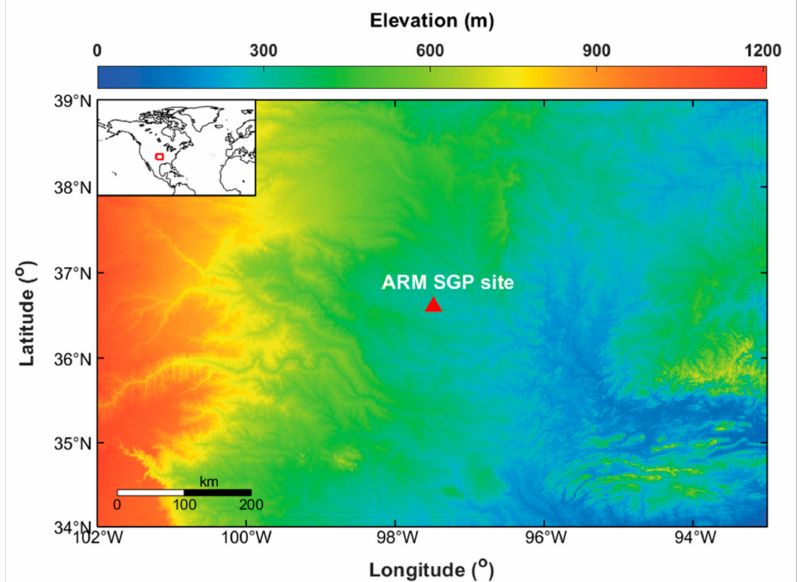
Figure 1. Location of the SGP sites of the ARM